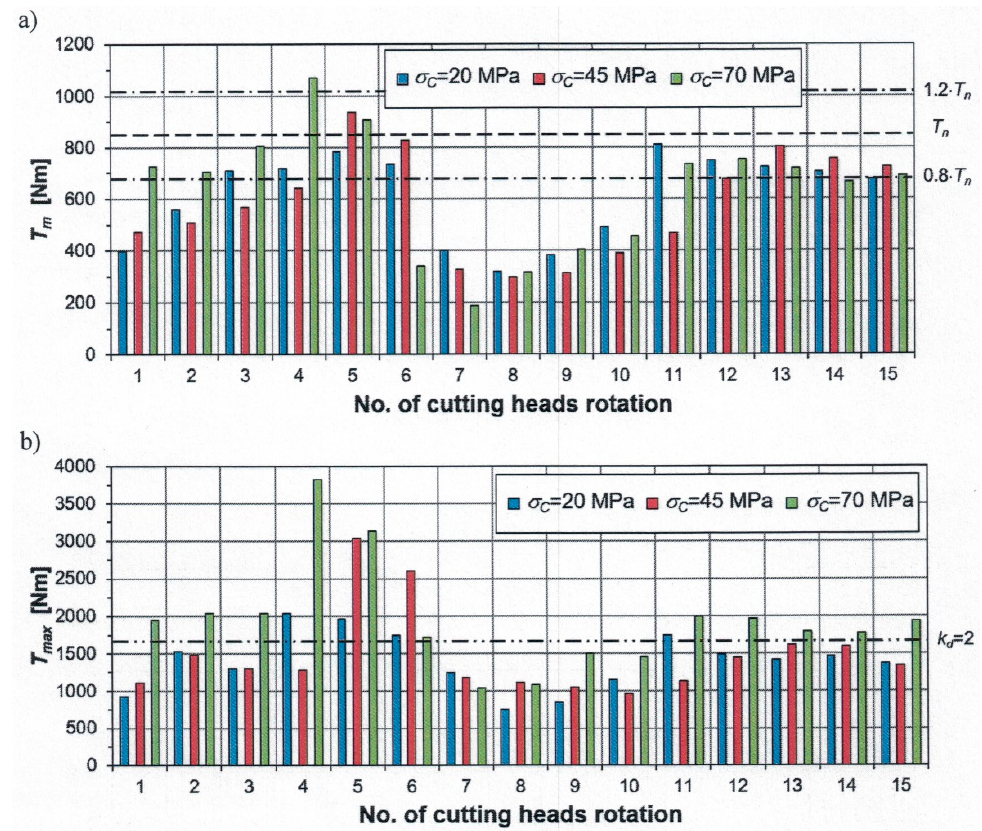
Figure 4. The course of: ( a ) the average value ( T m ) and ( b ) the peak value ( T max ) of torque on the motor shaft in the cutting heads drive in subsequent rotations of the cutting heads when making lower cuts in the automatic control mode in rocks with different uniaxial compressive strengths.